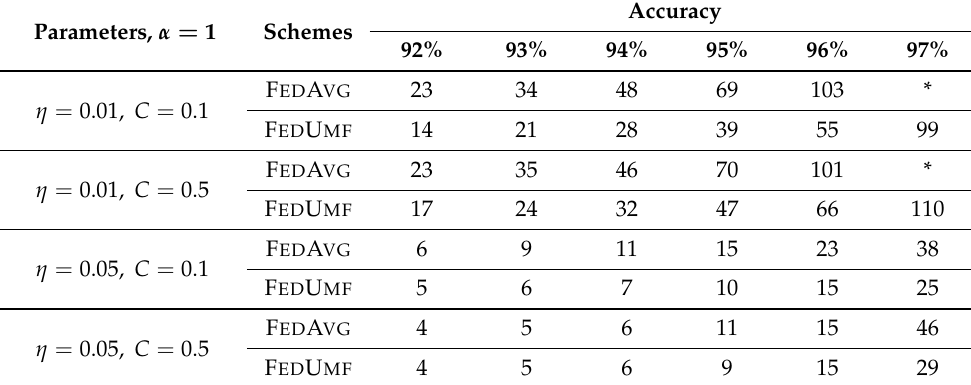
Table 1. Accuracy on MNIST dataset. IID